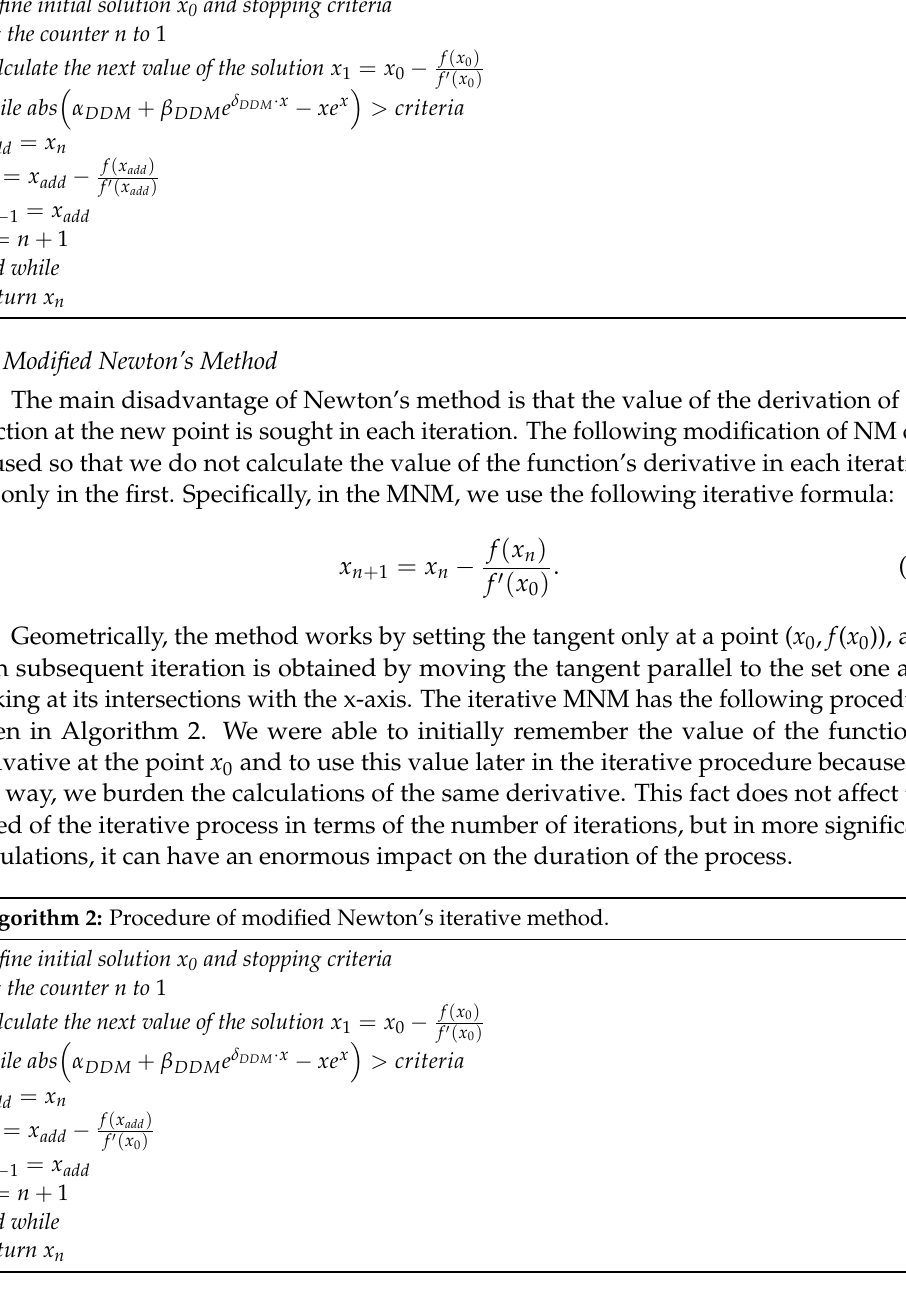
Algorithm 1: Procedure of Newton’s iterative method.